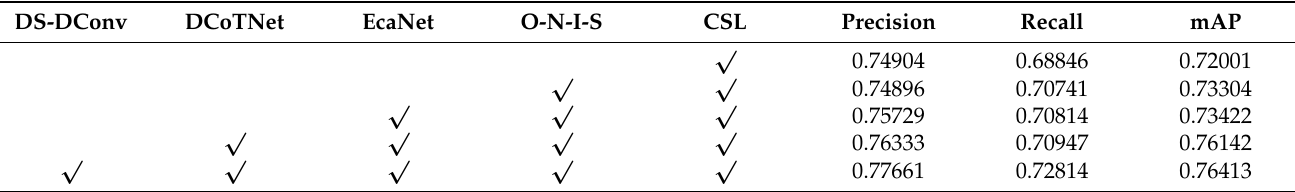
Table 7. Ablation study on DOTA